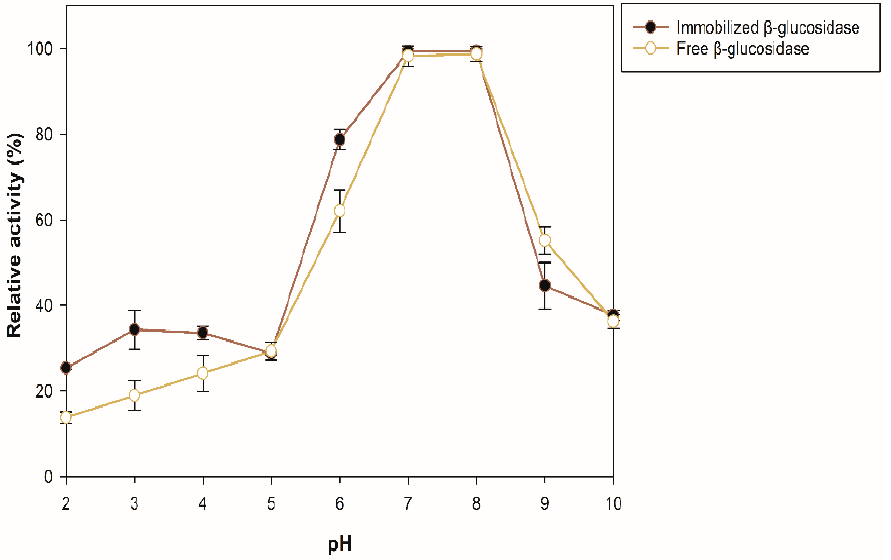
Figure 4. Stability of free and immobilized β -glucosidase at different pH.